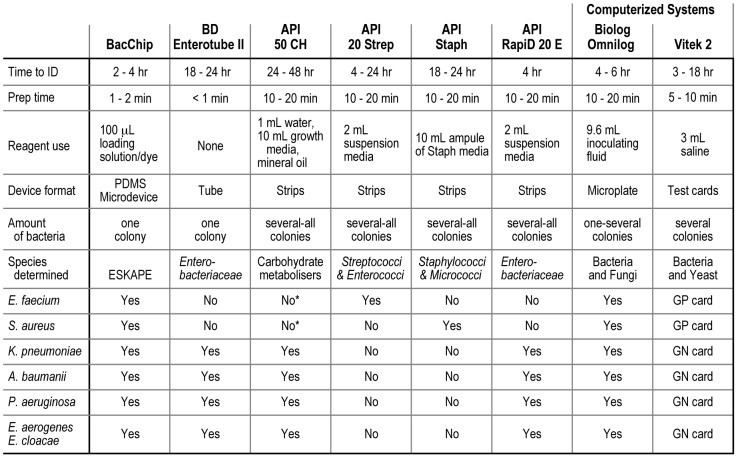
The BacChip versus current commercial diagnostics.A table comparing the BacChip device with commercial diagnostic systems that include comparable self-contained hand-held devices and advanced computerized systems. “Time to ID” refers to the identification time after a bacterium has been isolated and amplified (typically an additional 24–48 h required for all diagnostic devices listed). The designation ‘GN’ and ‘GP card’ for the Vitek 2 indicates that different test cards are required to identify these organisms. *The API 50 CH system is not marketed for Gram-positive bacteria nor does it have a GP database for identification of strains. However, the method of identification of the API 50 CH (carbohydrate metabolism) could in principle be used to determine Gram-positive bacteria.